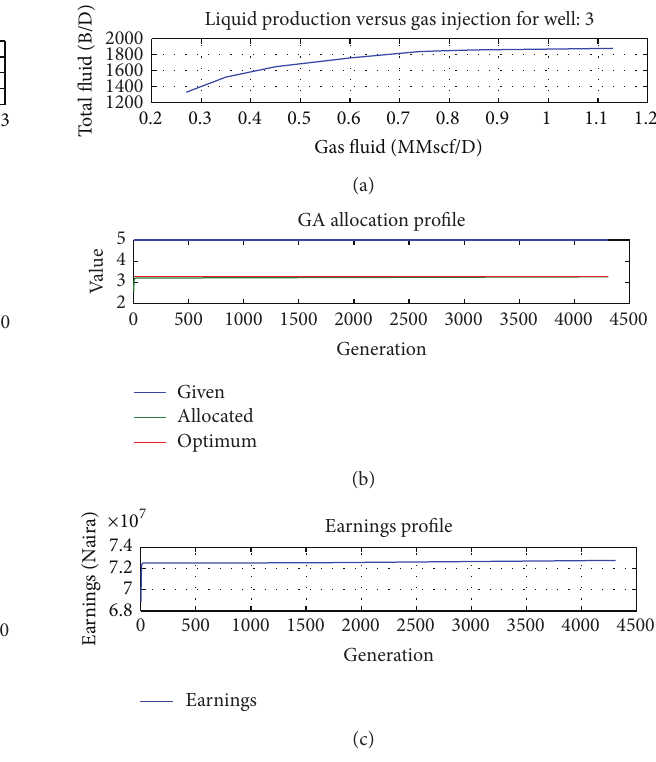
Figure 11: Well 3’s allocation profile, wells 1–3 GA allocation profile, and earnings (Naira) in an unlimited